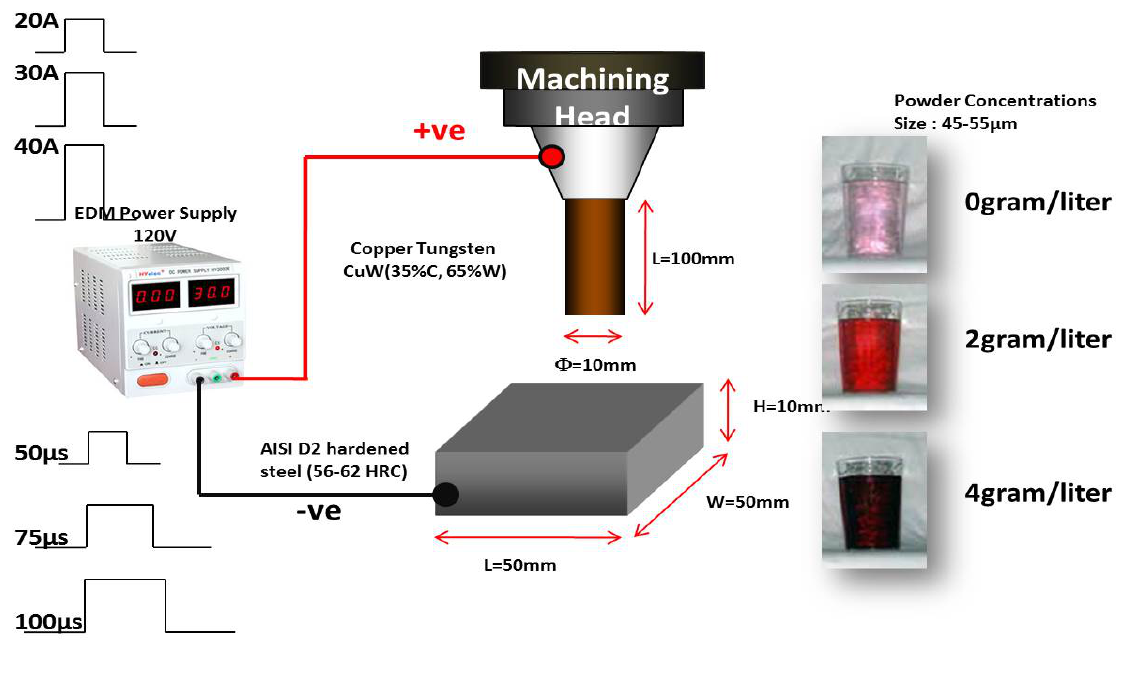
Figure 3: Overview research procedures